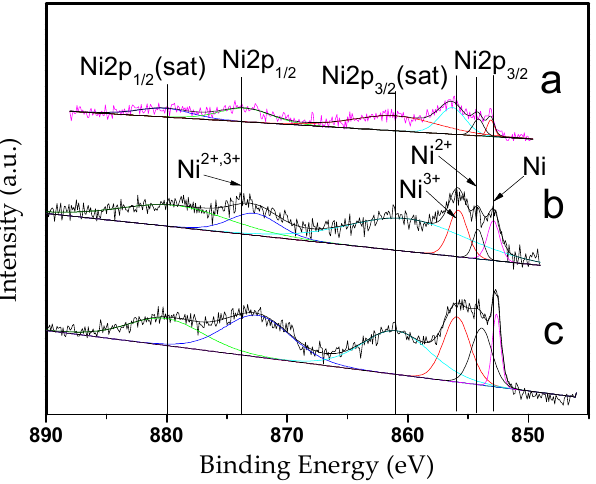
Table 2. XPS elemental composition of the catalyst surface.